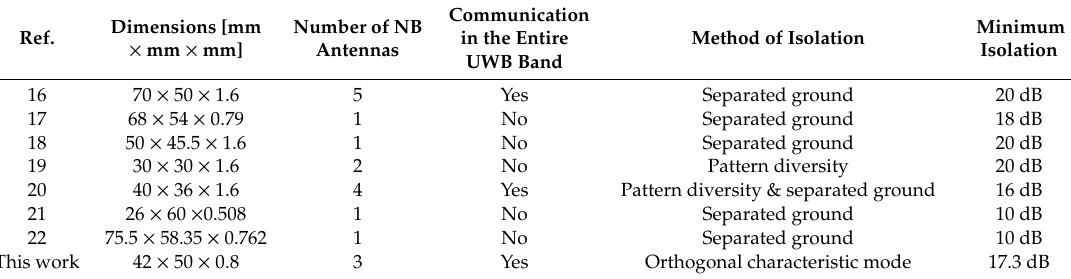
Table 3. Comparison of various integrated UWB and NB antenna systems.